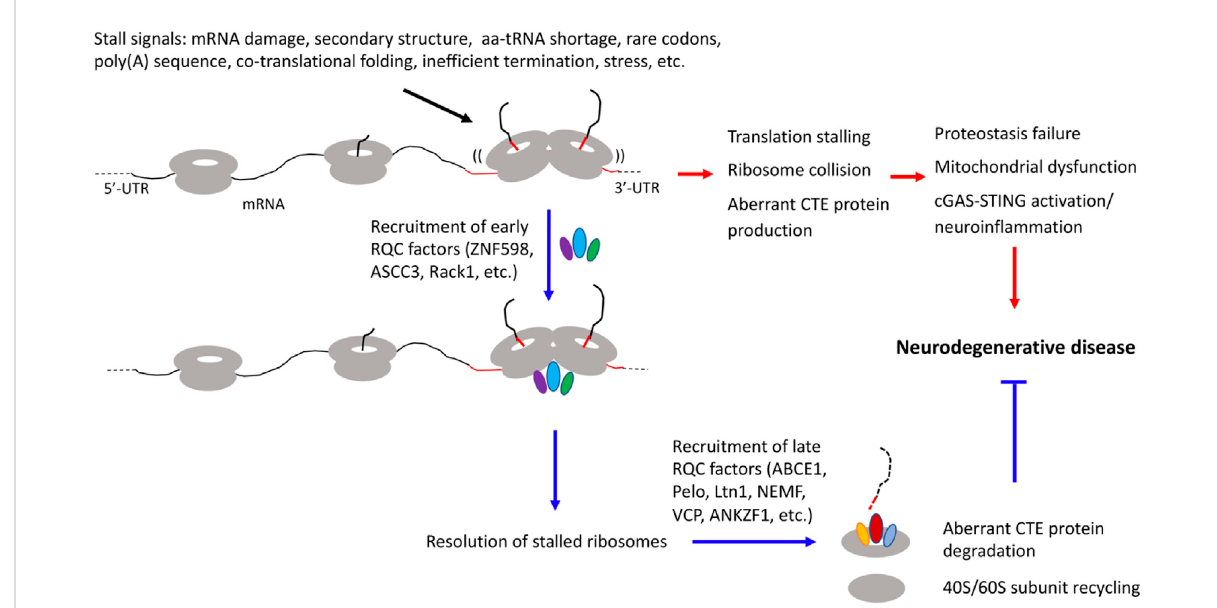
FIGURE 1 Diagram depicting diverse signals that can lead to translationstalling and ribosome collision and the effect of RQC factor recruitment to stalled ribosomes to resolve stalled translation and restoring cellular homeostasis, and how inadequate quality control of stalled translation and collided ribosomes may be linked to various hallmarks of neurodegenerative diseases, including proteostasis failure, mitochondrial dysfunction, and neuroin fl